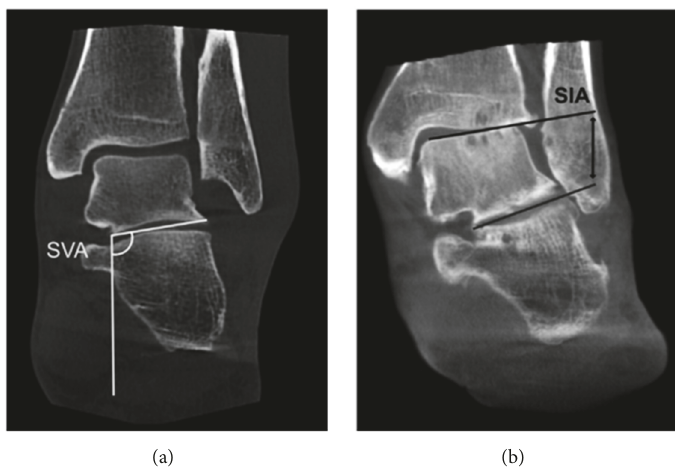
Figure4:(a)Correspondingweight-bearingcomputedtomography(CT)scan.Theorientationofthesubtalarjointtothegroundwasassessed using the subtalar vertical angle (SVA). (b) Corresponding weight-bearing CT scan. The subtalar inclination angle (SIA) was used to assess the inclination of the subtalar joint. Figure 4 is reproduced from Krahenbuhl et al. 2017